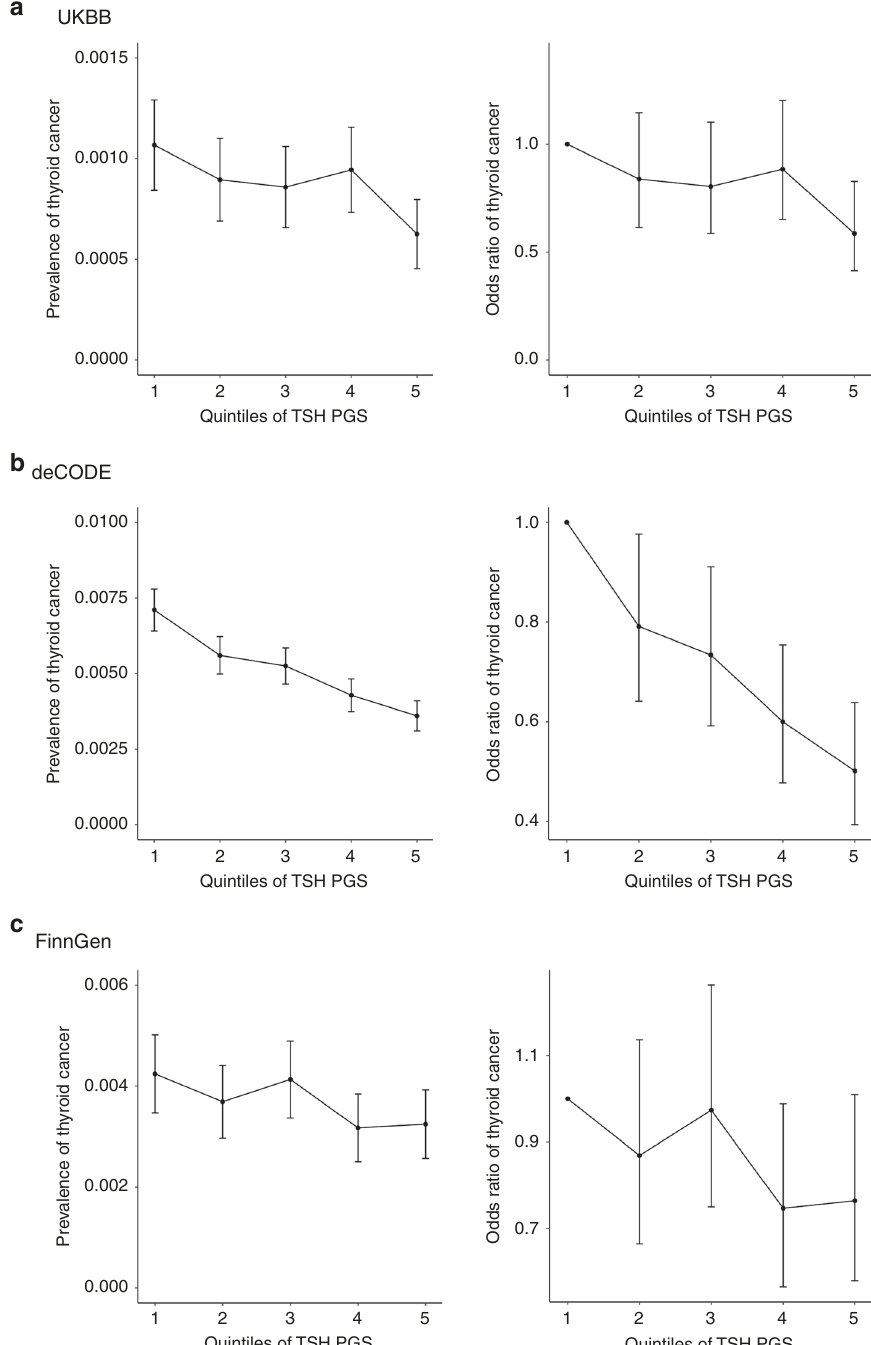
Fig. 2 The risk of thyroid cancer is lower for individuals with genetically predicted higher TSH levels. Plots of thyroid cancer prevalence by quintiles of TSH PGS (left) and odds ratio of thyroid cancer in relation to the lowest quintile (right) in data sets UKBB ( a ; N case = 358, N control = 407,399), deCODE ( b ; N case = 1003, N control = 278,991) 19 , and FinnGen ( c ; N case = 501, N control = 135,137). N : sample size. N case: sample size of cases. N control: sample size of controls. Error bars represent 95% con fi dence